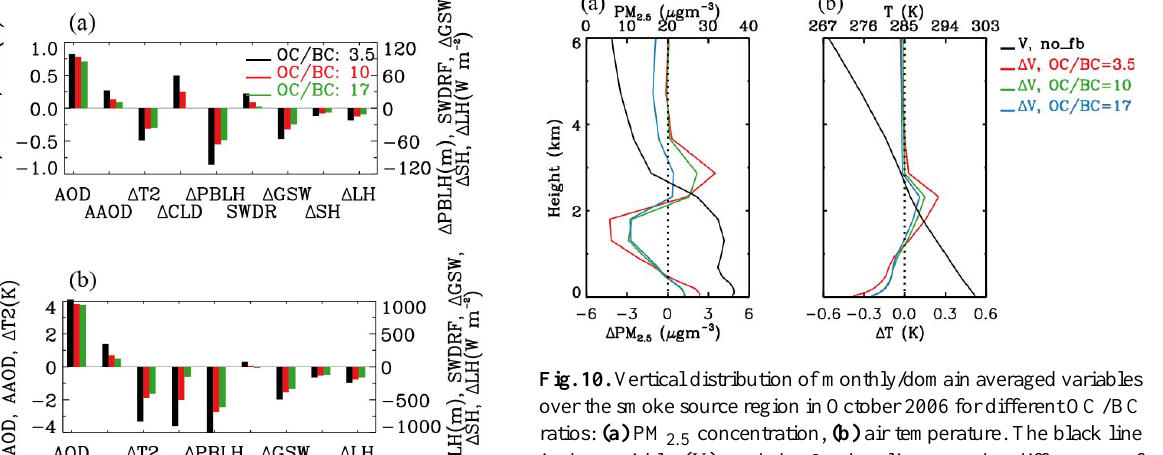
peak value is 2.5 and 3.2 µg m − 3 for OC / BC of 10 and 3.5,